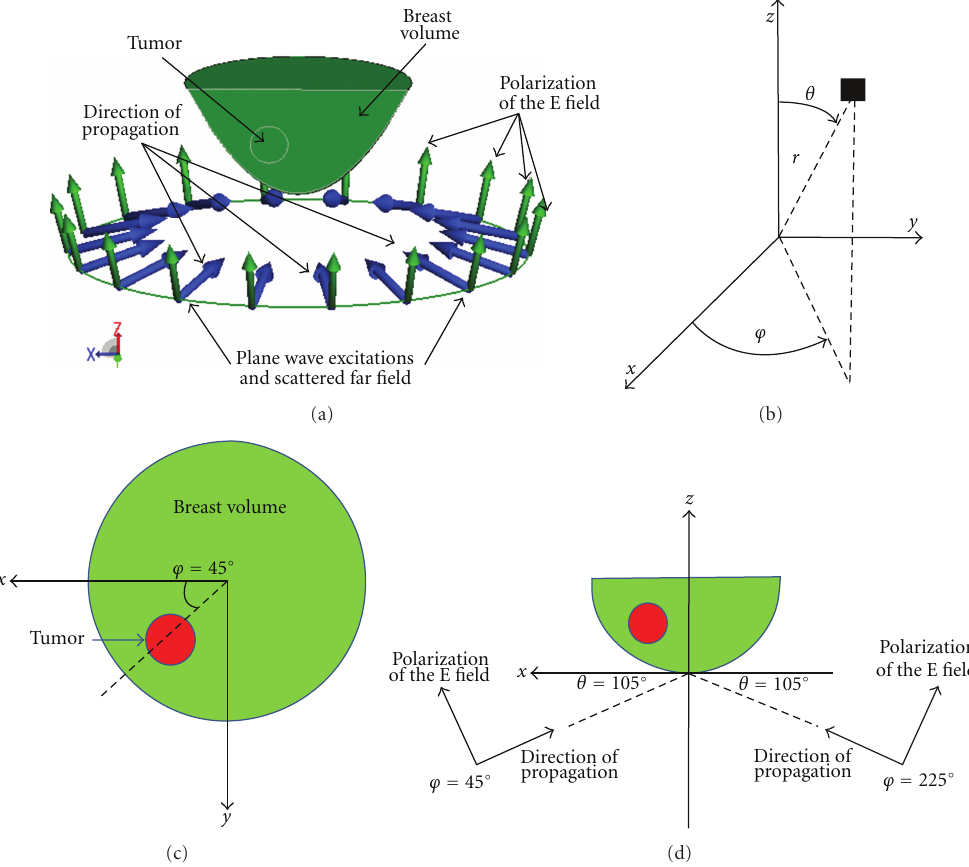
Figure 2: (a)The breast volume under plane wave illumination in FEKO environment. (b) The Spherical coordinate system ( r , θ , ϕ ) and the corresponding Cartesian coordinate system ( x , y , z ) that are used in the FEKO environment. (c) Cross-sectional views ( x - y plane) of the breast volume under plane wave illumination. (d) Cross-sectional view ( ϕ = 45 ◦ , θ = 90 ◦ ) of the breast volume under plane wave illuminations from θ t = 105 ◦ , ϕ t = 45 ◦ , and ϕ t = 225 ◦ ,